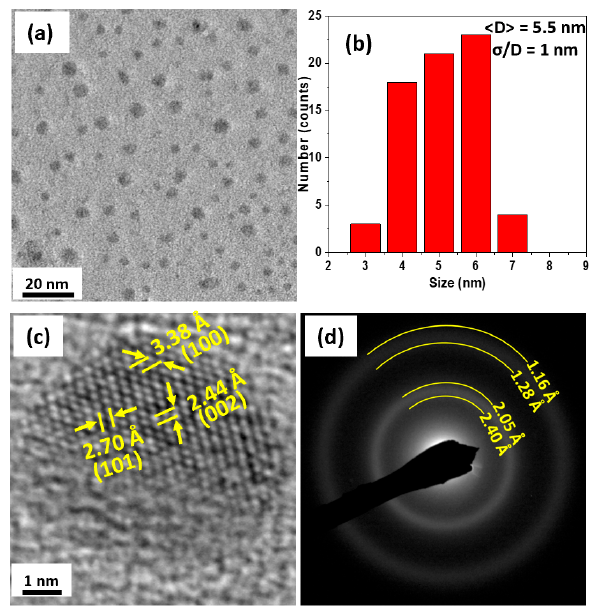
Figure 2. Transmission electron microscope (TEM) studies on the as-made NPs. Figures ( a – d ) show the particles observed by the TEM, their size distribution, the high resolution TEM (HR-TEM) and selected area diffraction (SAD) images of the as-made NPs, respectively.